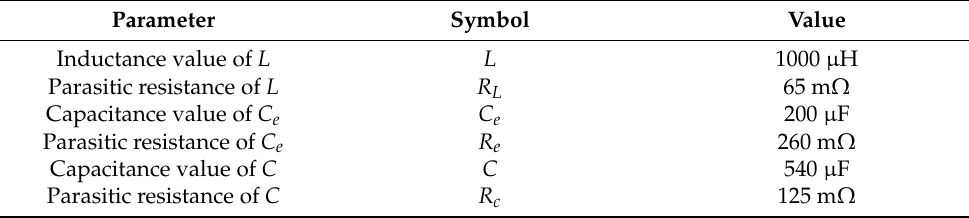
Table 4. Reactive components of the